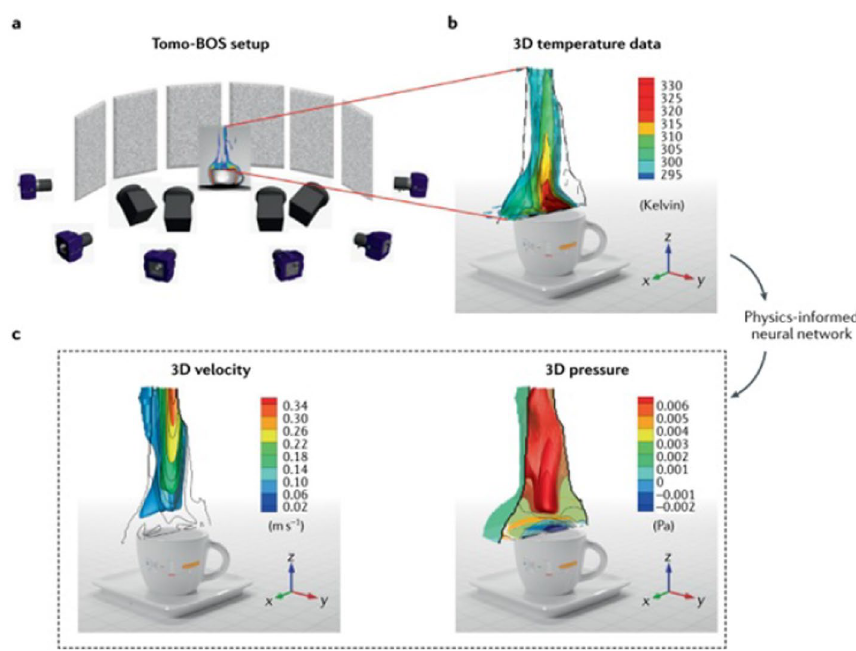
Fig. 25 An example of using a PINN‑based framework to study the fluid domain upon a cup of hot espresso coffee. Only the temperature and density images are used as the training data, which is traditionally considered to be insufficient to predict the corresponding velocity and pressure fields. a The training data in terms of the 3D temperature and density images are captured by the Tomo‑BOS system; b an example of the 3D captured temperature image from a ; c the captured images are fed to a PINN to predict the corresponding 3D velocity and pressure fields (Adopted from [474])